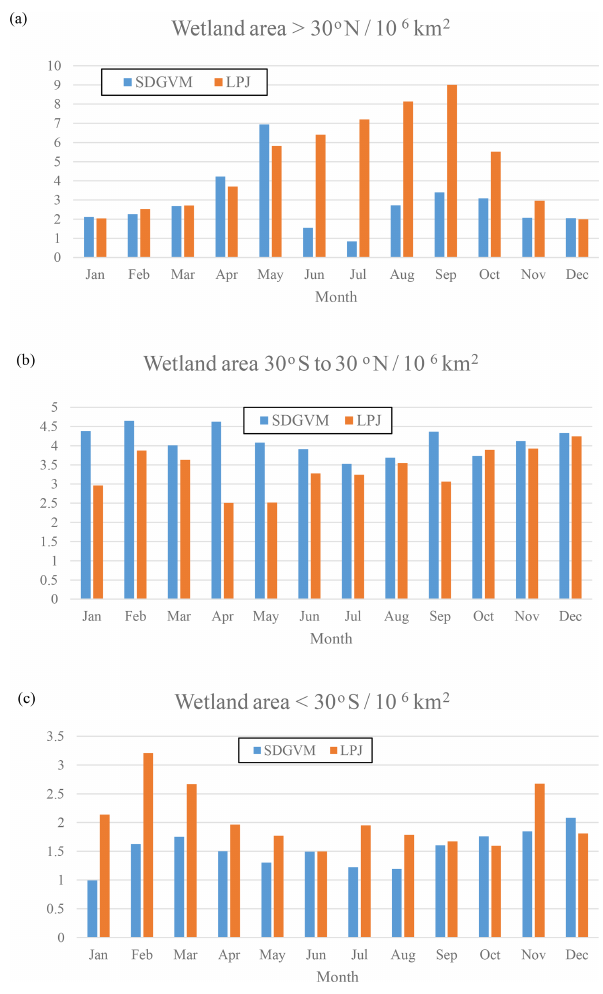
Figure 8. Monthly variations in total wetland area calculated for the Eocene climate by SDGVM and LPJ for (a) all areas north of 30 ◦ N, (b) all areas between 30 ◦ S and 30 ◦ N and (c) all areas south of 30 ◦ S.